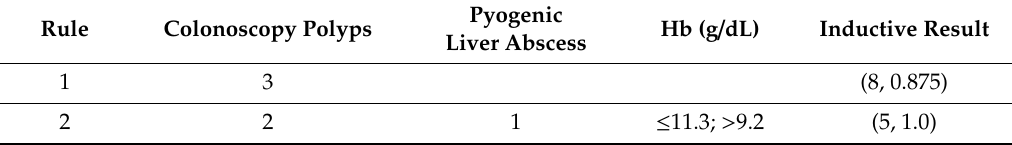
Figure 4. Decision tree model 2 (pyogenic liver abscess variable). Table 11. Model 2 (with bacterial liver abscess) classification results—colorectal cancer.